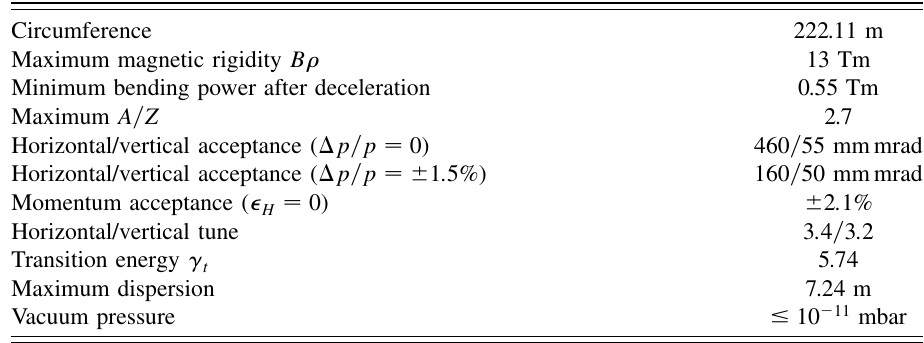
TABLE I. NESR ring